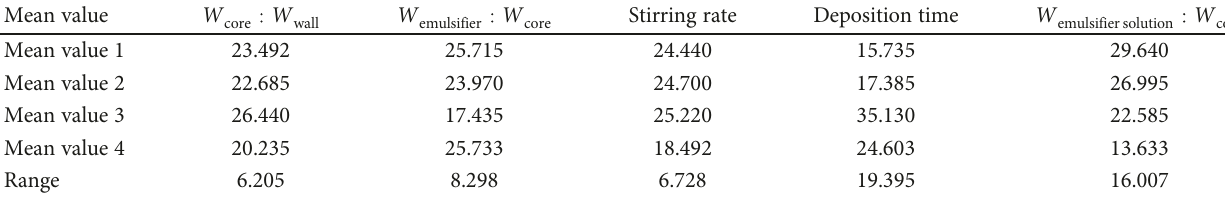
Table 6: Range of microcapsule yields.